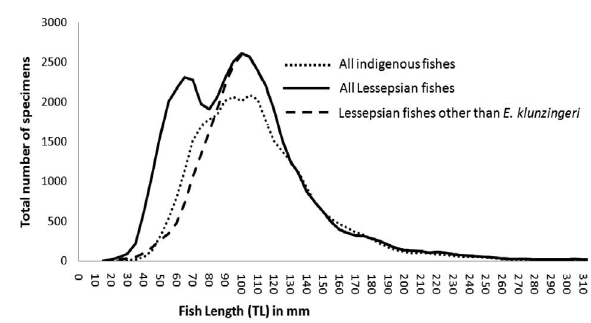
Fig. 5. – Size composition (Two point moving average on the x axis) of all 72812 fishes caught in the present study, with special refer- ence to the small non-indigenous ponyfish Equulites klunzingeri